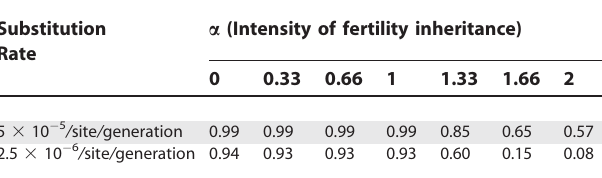
Table 6. The Effect of Fertility Inheritance on Heterozygosity Substitution Rate